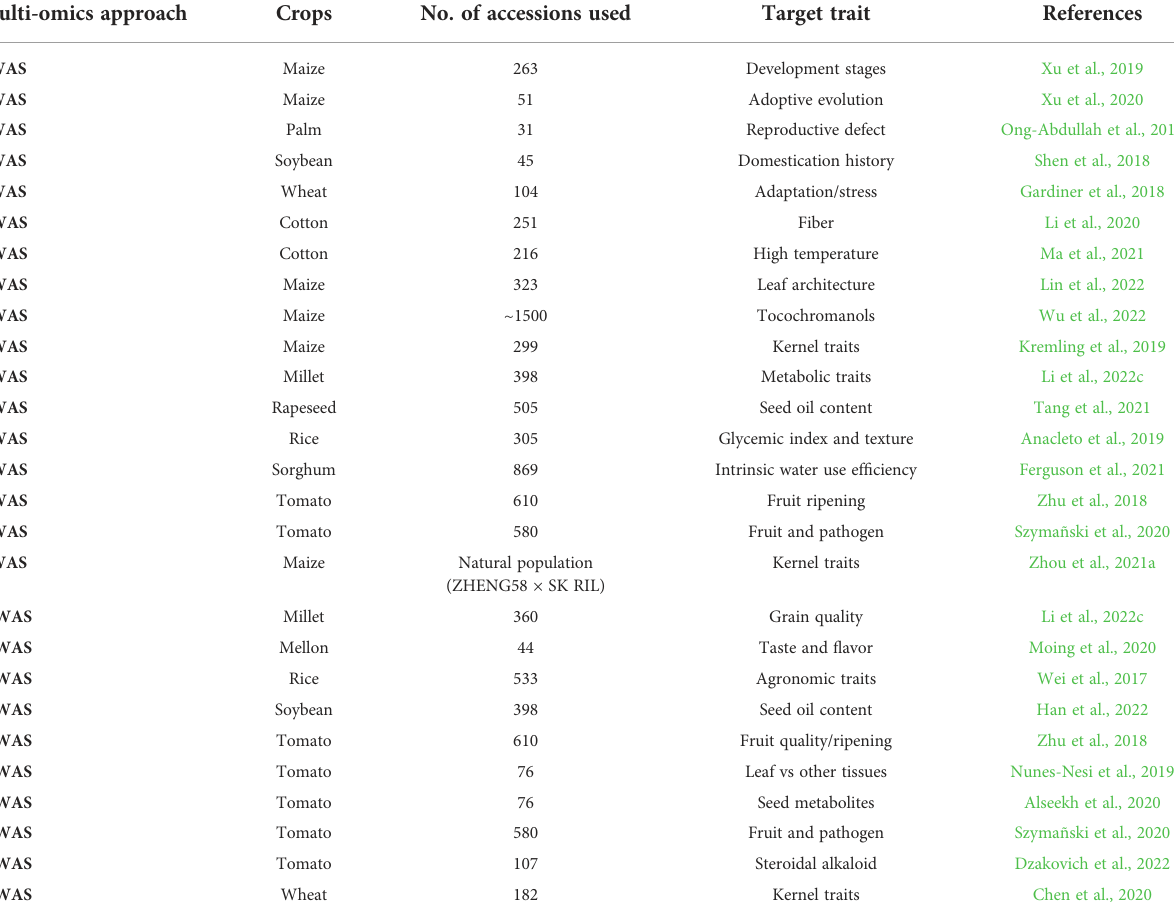
TABLE 2 Recent GWAS studies combined with RNA, protein, and metabolites to fi nd the target traits in breeding programs. Multi-omics approach Crops No. of accessions used Target trait